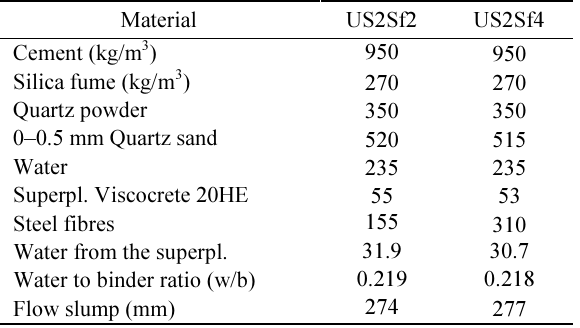
Fig. 3. Compressive strength test results on samples of